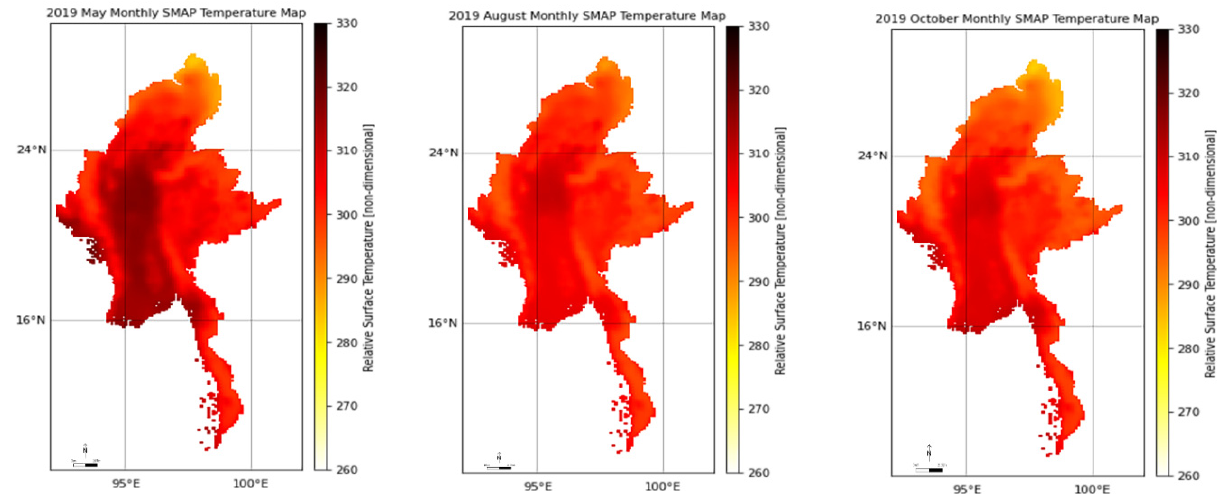
Figure 5. Surface temperature received by the SMAP Radiometer in May, August, and October 2019.